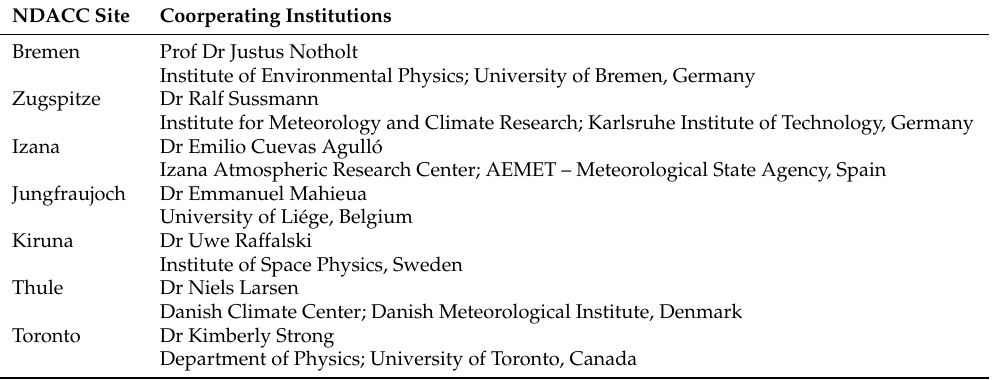
Table A1. NDACC sites used in this publication along with the stations’ representative and cooperating